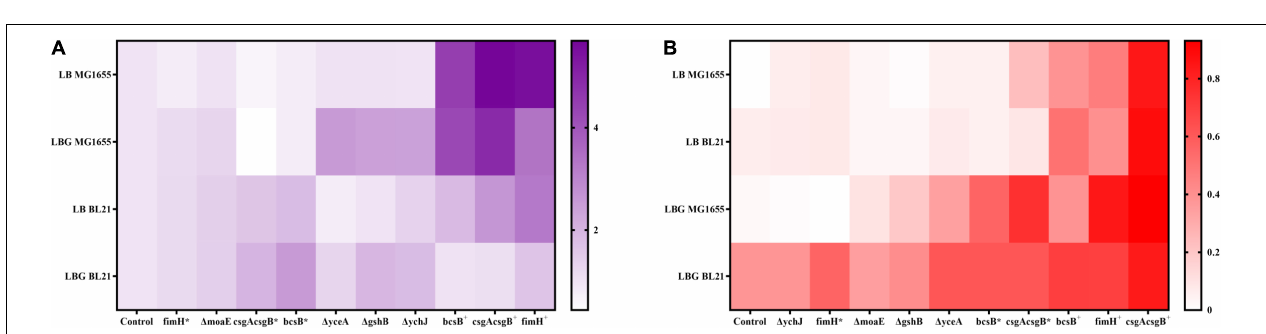
FIGURE 4 | A summary and heat map illustration of (A) fold changes in biofilm biomass and (B) CR adsorption for different E. coli recombinant strains. Data is processed as described in Supplementary Material .